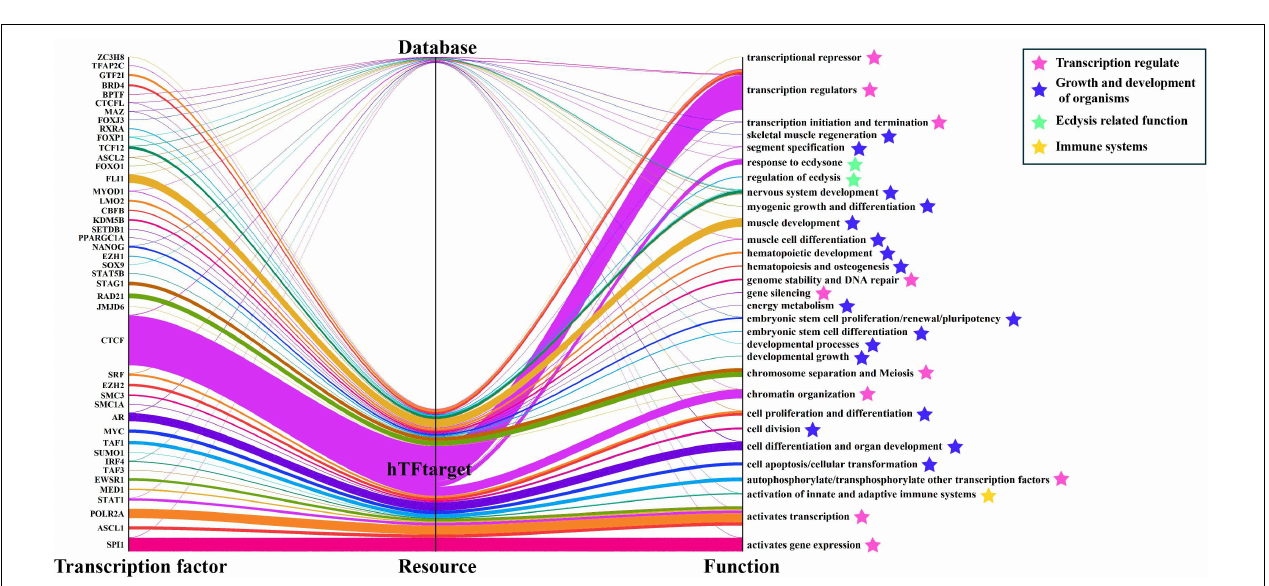
FIGURE 3 | Predicted 3D structure of LvGSK3. (A) Predicted 3D structure of LvGSK3. Green represents tyrosine 214 residues. (B) Predicted 3D structure of LvGSK3. White represents arginine 94 and 178 residues; green represents lysine 203 residues. β -Sheet is in yellow, helix is in blue, β -turn is in cyan, and random coil is in white.